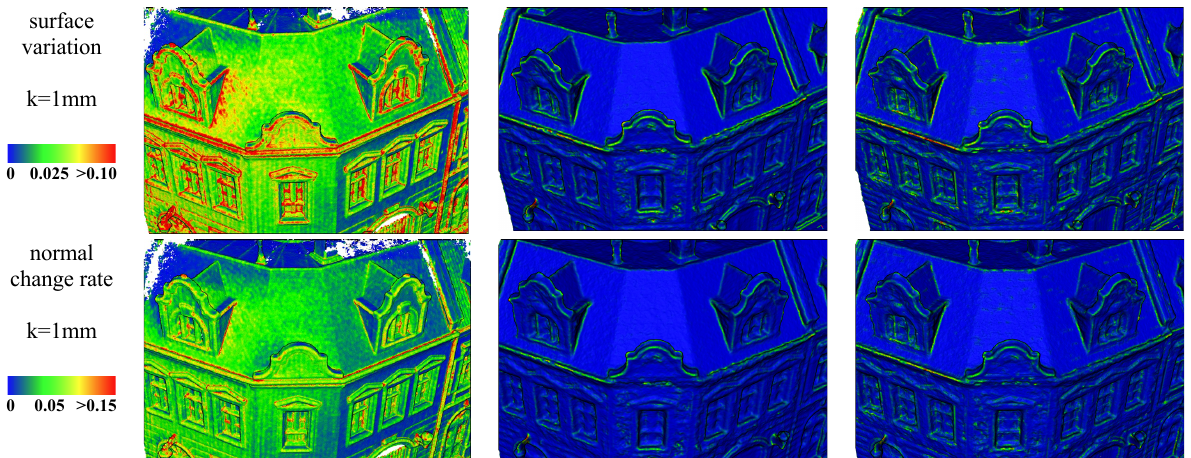
Figure 8. DTU-006: surface variation and normal change rate for GT (left), standard mesh (centre), mesh with edges